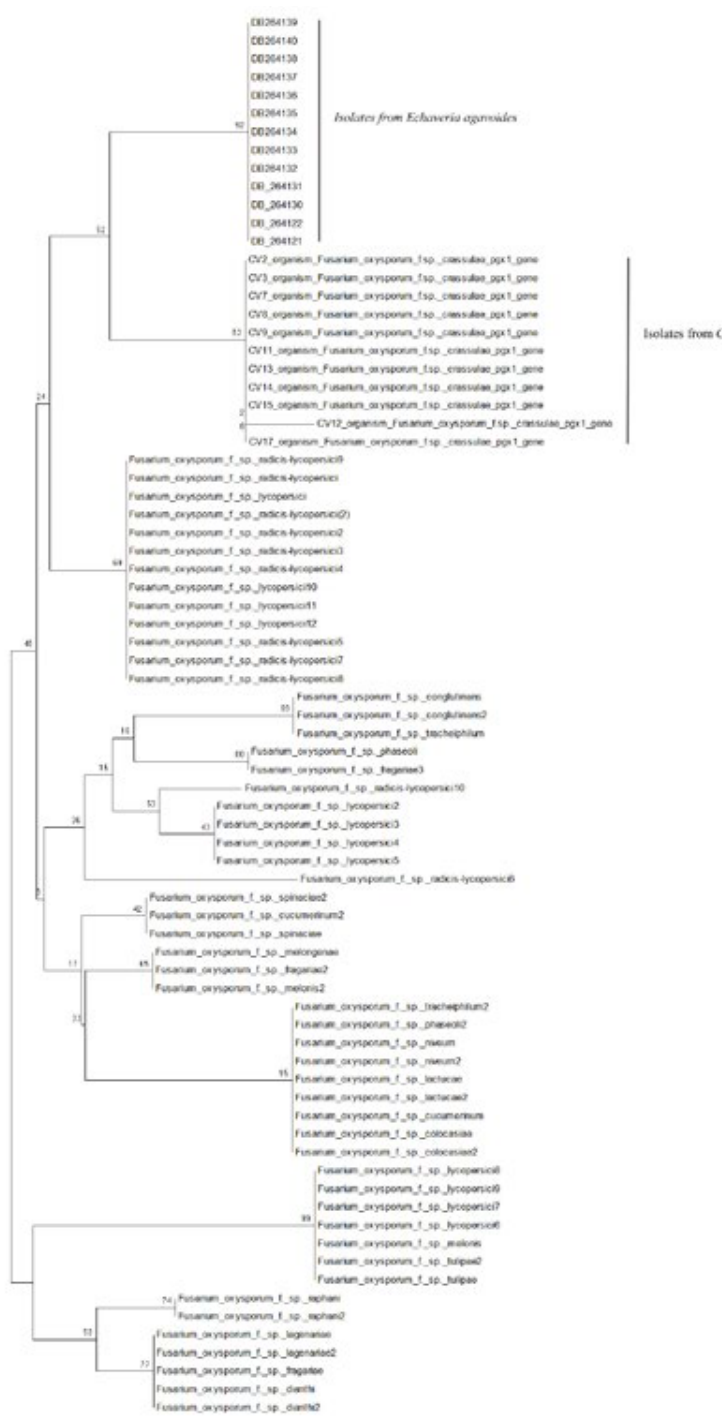
Figure 4. Phylogenetic tree based on Pgx1 gene sequences, built by Mega5 software with the Neighbour joining method with 1,000 bootstrapping